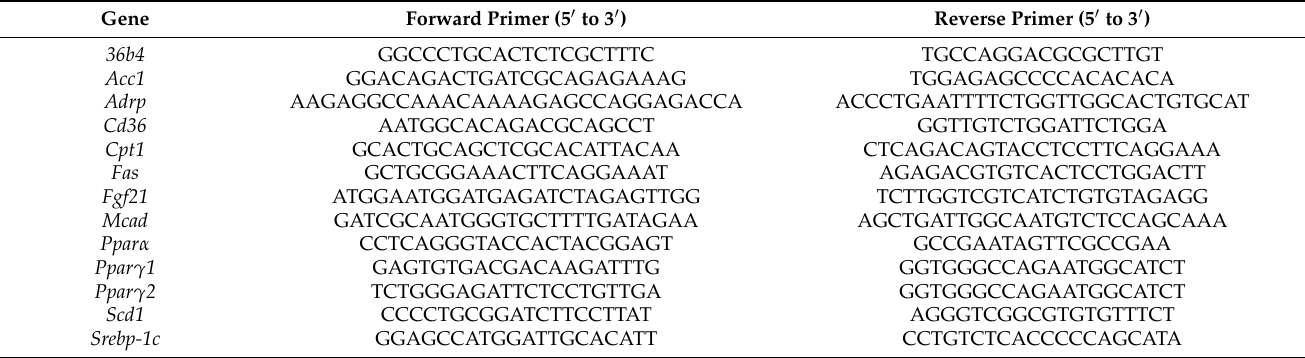
Table 2. Primers used for quantitative real-time